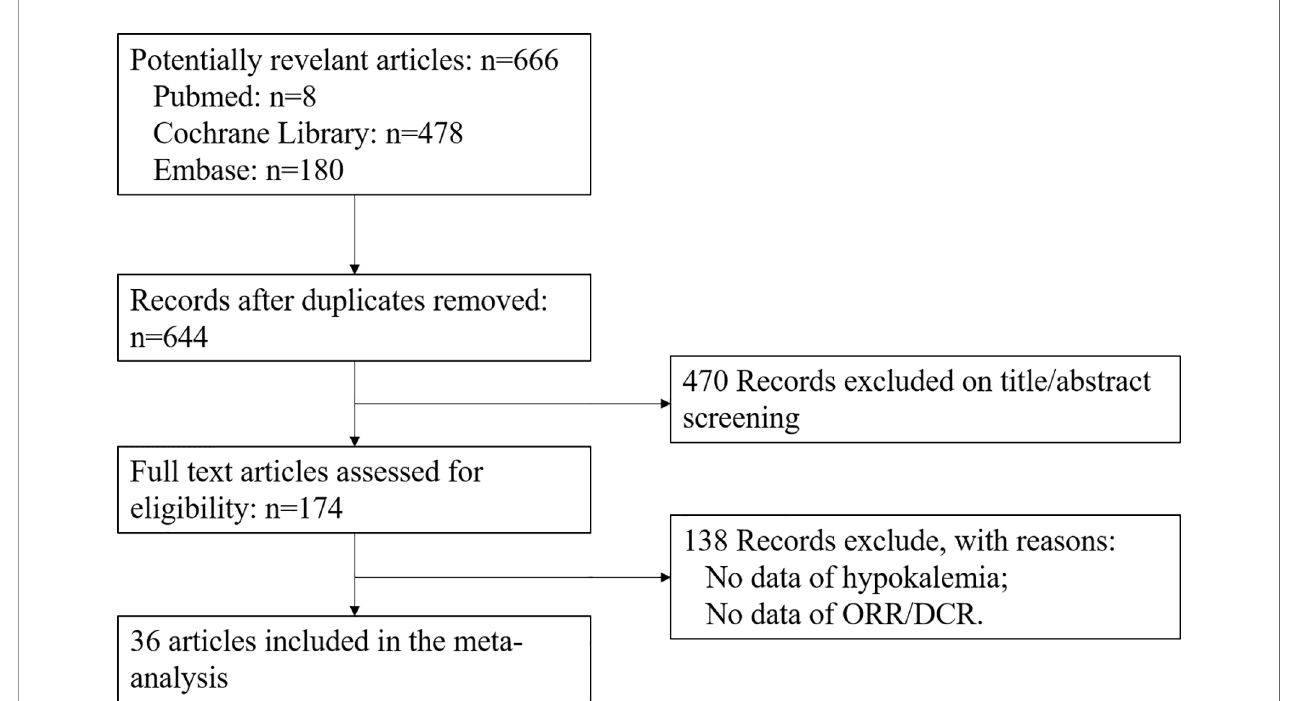
FIGURE 1 | Outline of the literature search